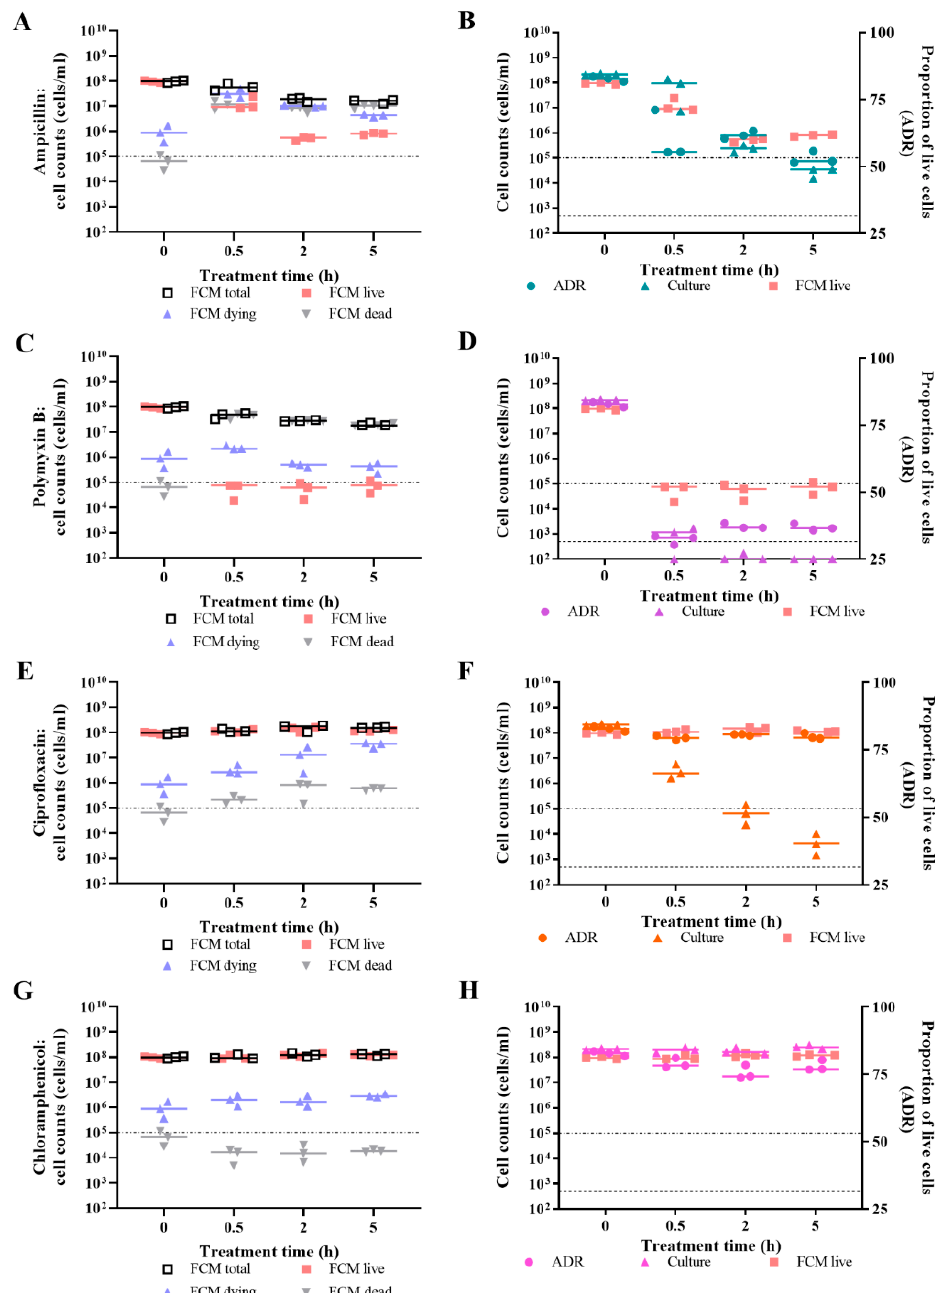
Figure 7. Flow cytometry of E. coli challenged with antibiotics. At 0 h, 0.5 h, 2 h, and 5 h time points, viability of E. coli MG1655 challenged with ~1× MBC of ampicillin ( A , B ), ~1× MBC of polymyxin B ( C , D ), ~1× MBC of ciprofloxacin ( E , F ), and ~1× MIC of chloramphenicol ( G , H ) was determined by measuring fluorescence of SYTO 9- and PI-stained cultures using the Optrode ( B , D , F , H ) and a LSR-II flow cytometer ( A , C , E , G ) and by culture-based enumeration ( B , D , F , H ). FCM generated a total cell count, live cell count, dying cell count, and dead cell count ( A , C , E , G ). The dot-dash line represents the limit of quantification for FCM (1 × 10 5 cells/mL). For Optrode measurements, fluorescence intensities were obtained from integrating 505–515 nm for green emissions and 600–610 nm for red emissions. The proportion of live cells in the sample population was determined by the adjusted dye ratio (ADR; B , D , F , H ). The limit of detection for culture-based enumeration is 500 CFU/mL (dashed line). Data presented is from three biological replicates with a line plotted at the median.